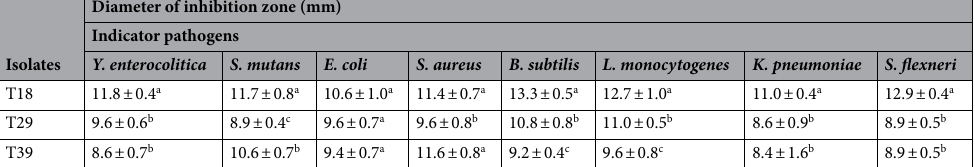
Table 3. The inhibitory effect of selected LAB strains against pathogens. Values shown are means ± standard deviations (n = 3). *Values are mean ± standard deviation of triplicates. S (strong r ≥ 20 mm), M (moderate r < 20 mm and > 10 mm), and W (weak ≤ 10 mm). a–d Means in the same row with different lowercase letters differed significantly ( p ≤